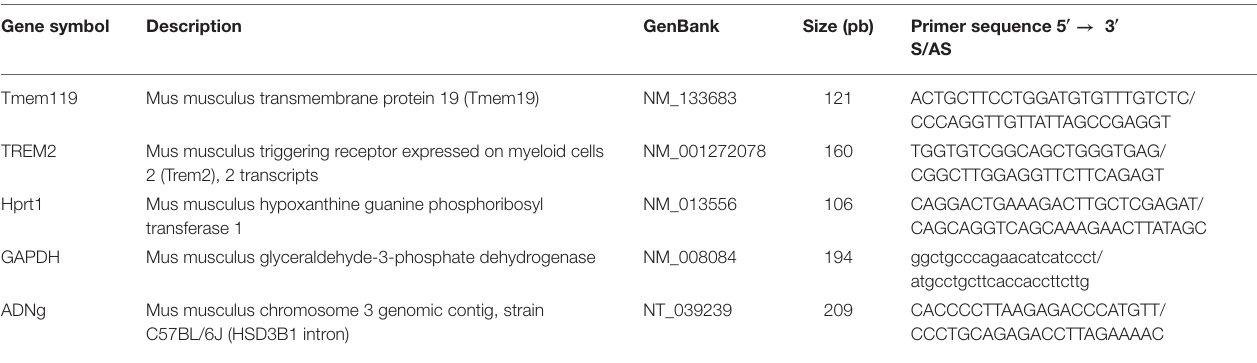
TABLE 1 | Sequence primers and gene